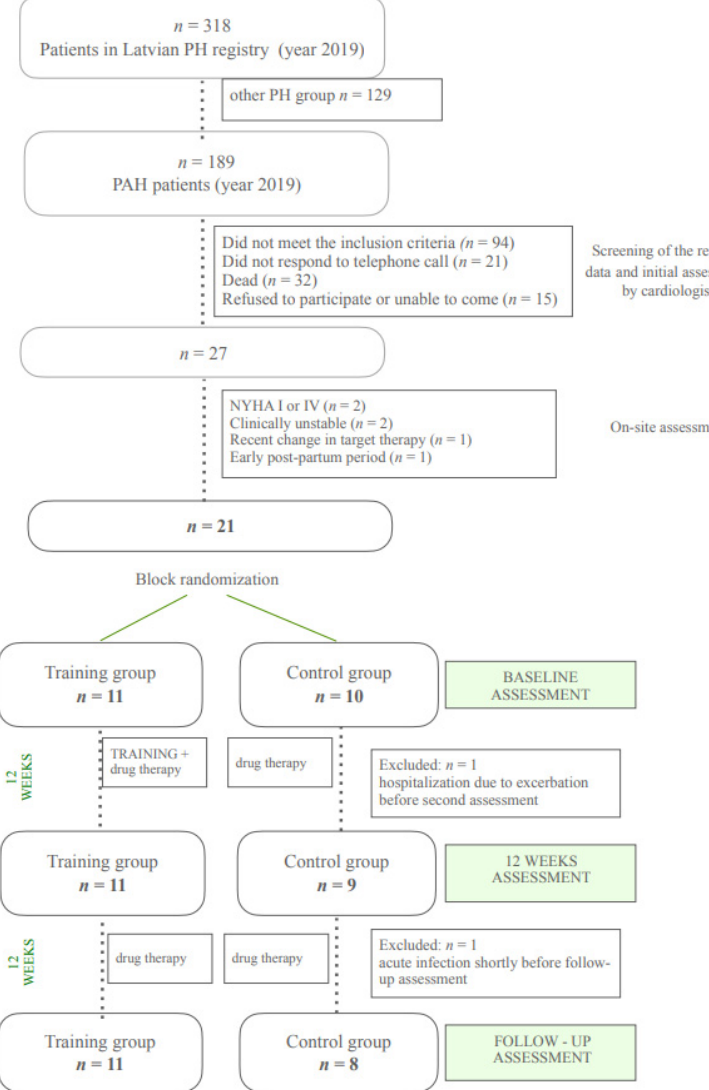
Figure 2. The study flow chart.